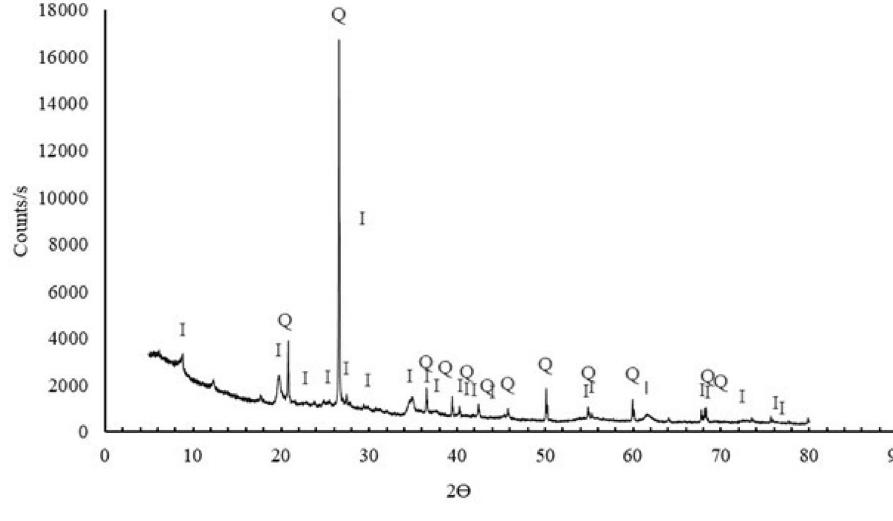
Fig. 4 Yellow clay mineral composition obtained by X-ray diffraction (Q-quartz; M-Mus- covite;